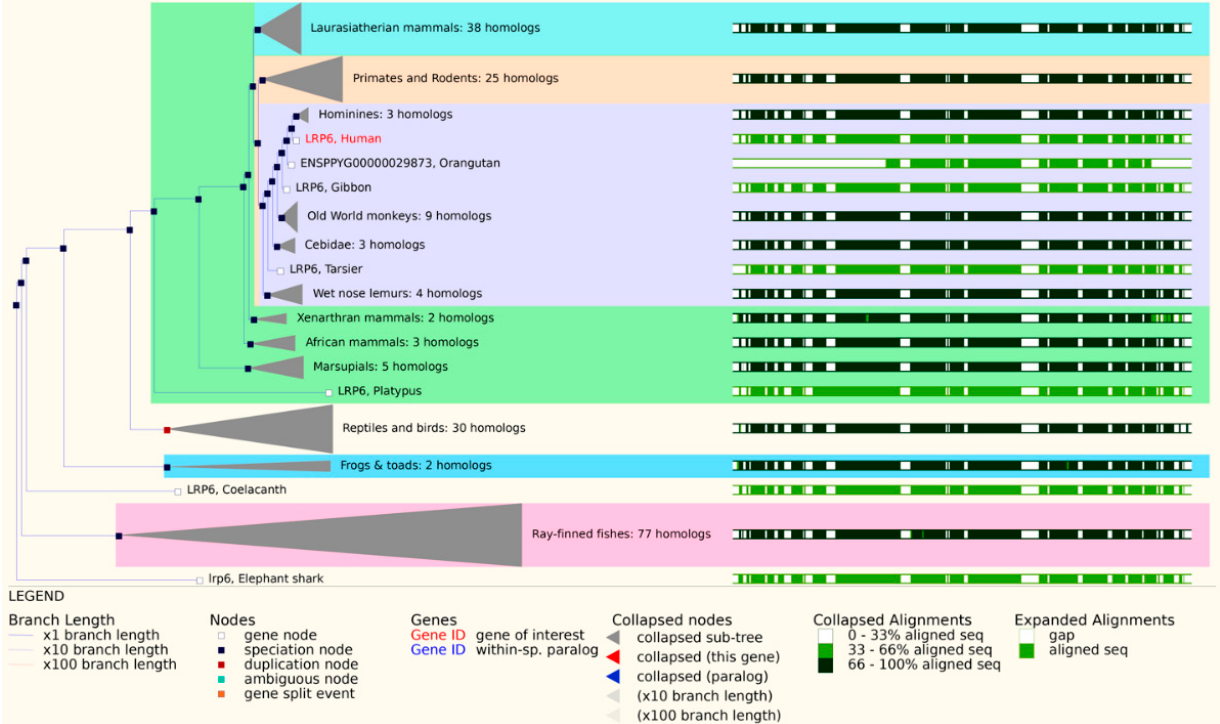
Figure 3. Gene homology tree showing human LRP6 in comparison to LRP6 homologs in other species in the animal kingdom (Ensembl reference number: GeneTree ENSGT00940000158990).